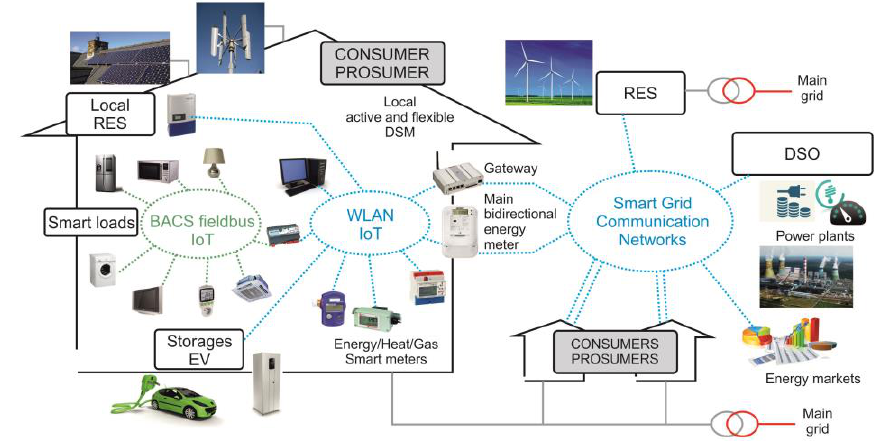
Figure 2. A communication and technical infrastructure of prosumer microgrid with its connection to the external smart grid and services.